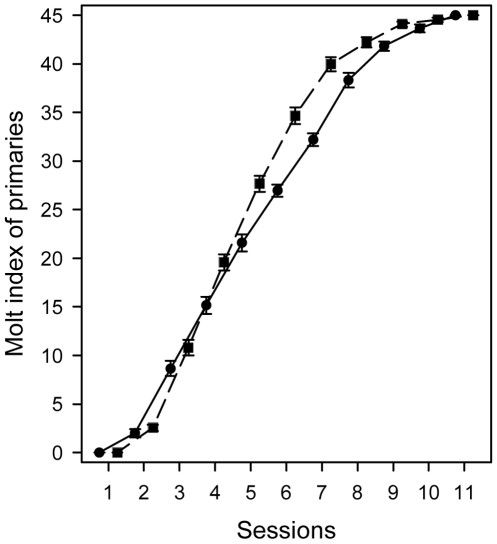
Change in primary molt index during the course of experiment.Male house sparrows from the accelerated ‘EP’ photoperiod group (rectangles and broken line) finished molting two weeks faster than birds in the natural-like ‘CP’ photoperiod group (circles and continuous line). First session is the date of capture (25th July 2008), then each session comes after 10-day intervals. Mean ± SE are shown.